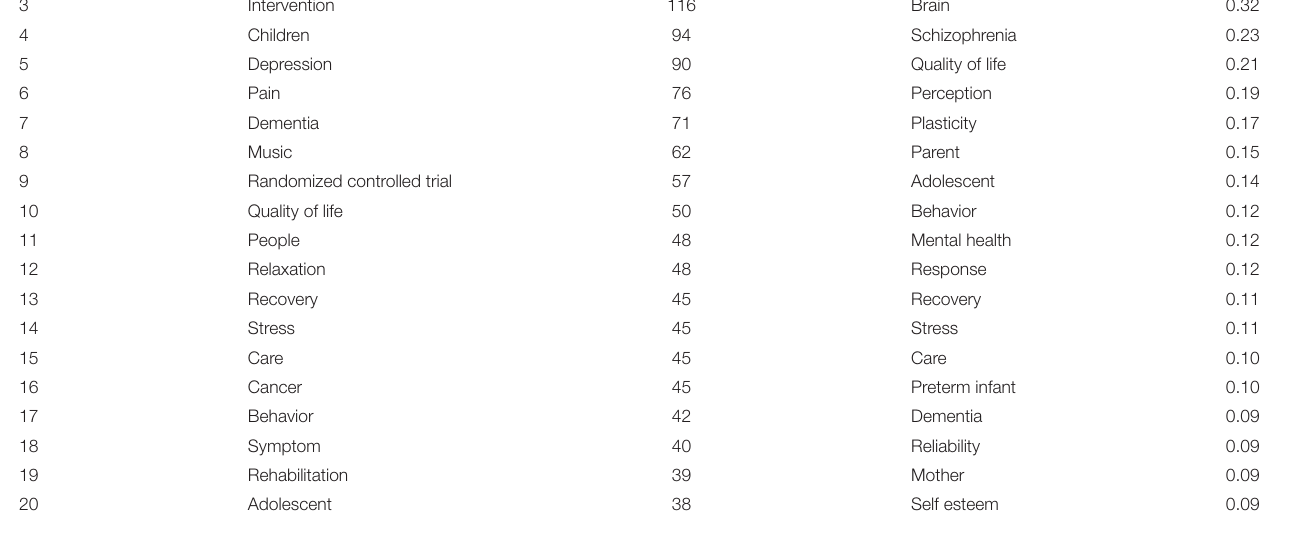
TABLE 5 | Top 20 keywords with the most frequency and centrality in music therapy study.